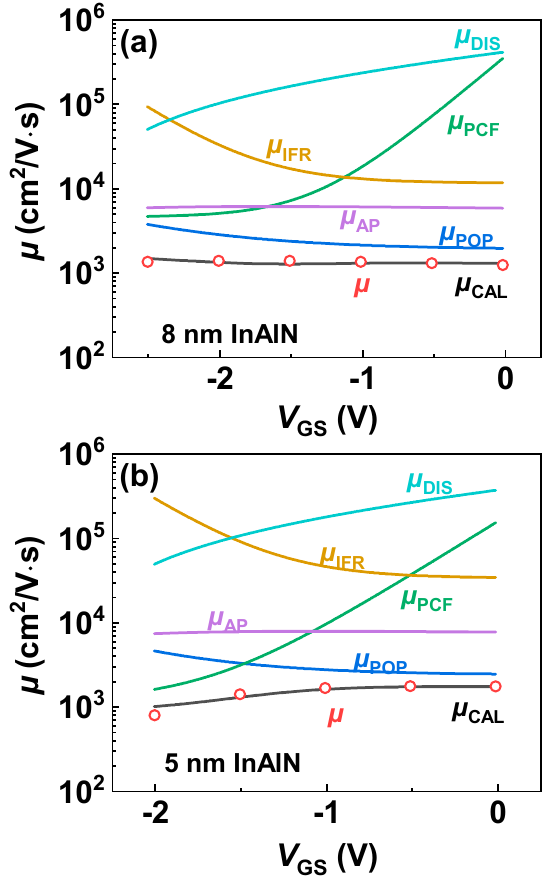
Figure 6. ( a , b ) Calculated µ limited by different scattering mechanisms, extracted µ ( µ , scatters), and calculated µ ( µ CAL , lines) versus V GS of both samples.